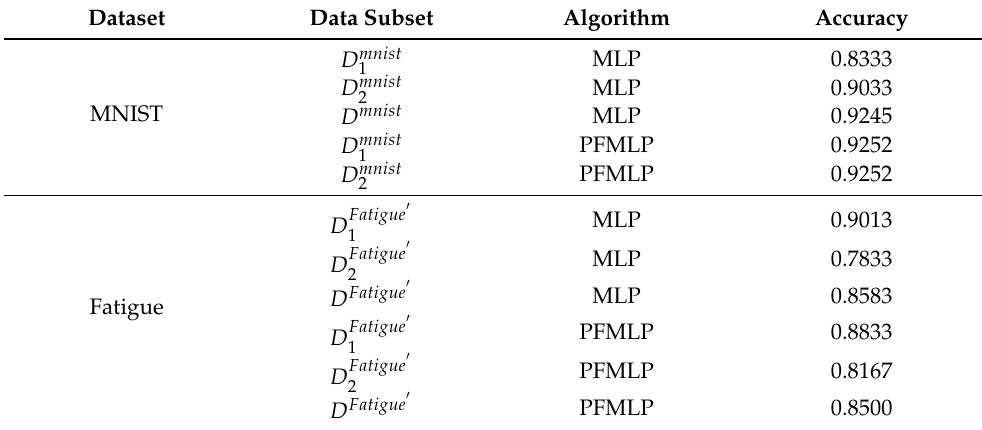
Table 4. Comparison results of prediction accuracy of MLP and PFMLP on two